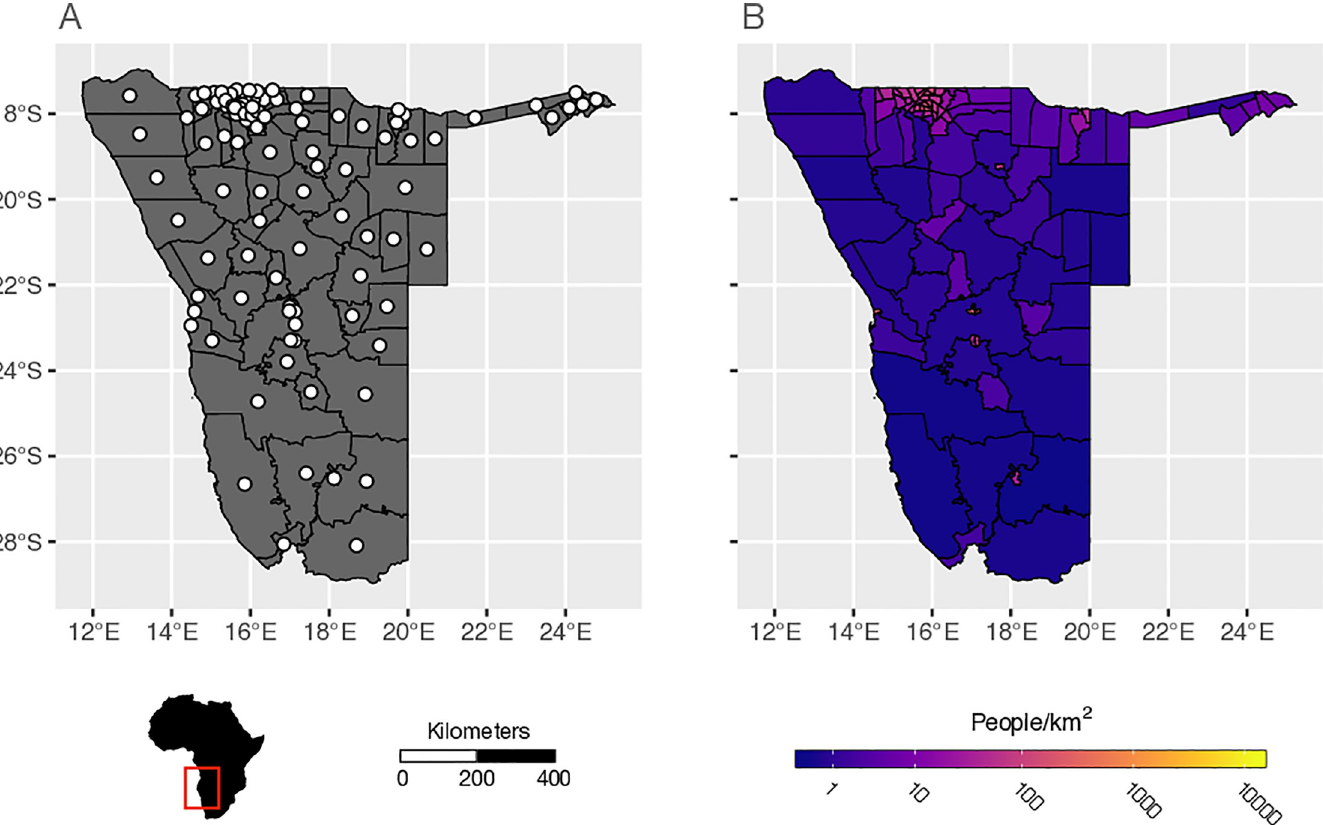
Fig 1. The Administrative districts and population distribution in Namibia. A) The locations of the 105 districts (administrative level 2) in Namibia with district centroids of each shown with white circles. B) The population density of each district in calculated as the number of people per square kilometer from the 2010 WorldPop Project estimates of the total number of people per 100m grid cell within each district (www.worldpop.org). District-level shapefiles were acquired from DIVA-GIS (www.diva-gis.org) and are reused here under the Creative Commons Attribution License.